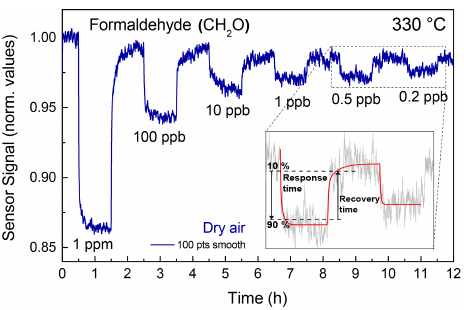
Figure 7. Sensor response to different concentrations of formalde- hyde (CH 2 O) from 1ppm to 0.2ppb at 330 ◦ C in dry air. The sensor signal is filtered to reduce the electronic noise. The value 100pts smooth is equivalent to a sampling time of 100ms.